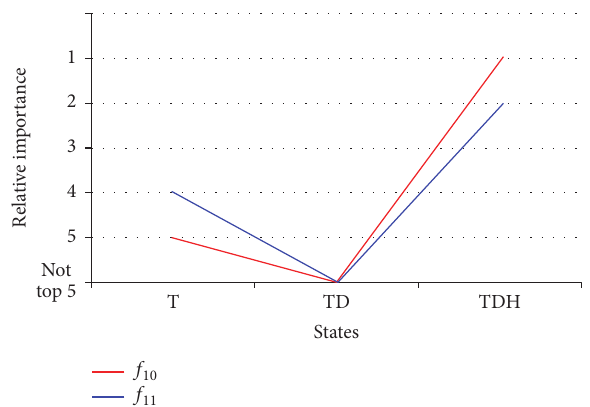
Figure 13: Parameter shift along the process sequence; the vertical axis indicates the relative importance by ranks